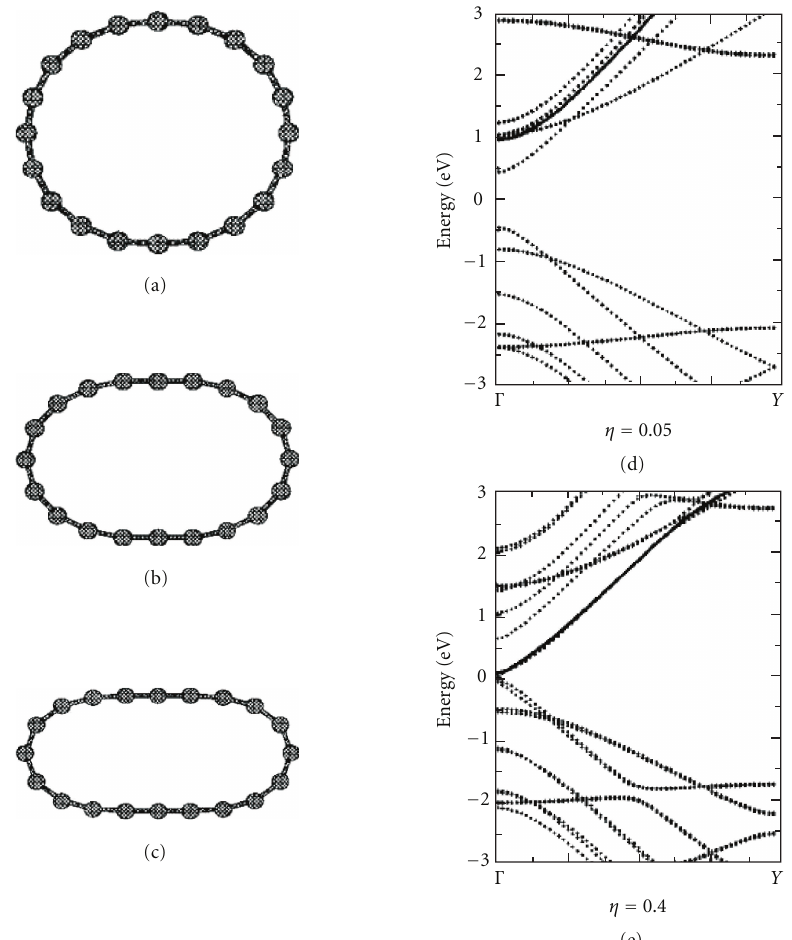
Figure 1: Relaxed cross-sections (a) of (10,0) carbon nanotubes with di ff erent degrees of flattness in (b) and (c). (d) and (e) plot the electronic band structures for a flattened (10,0) nanotube. The flatness is characterized by η which is defined as η = ( D 0 − d ) /D 0 , where D 0 is the original diameter of the nanotube and d is the distance between two straight lines of the cross-section (adapted from [13]).